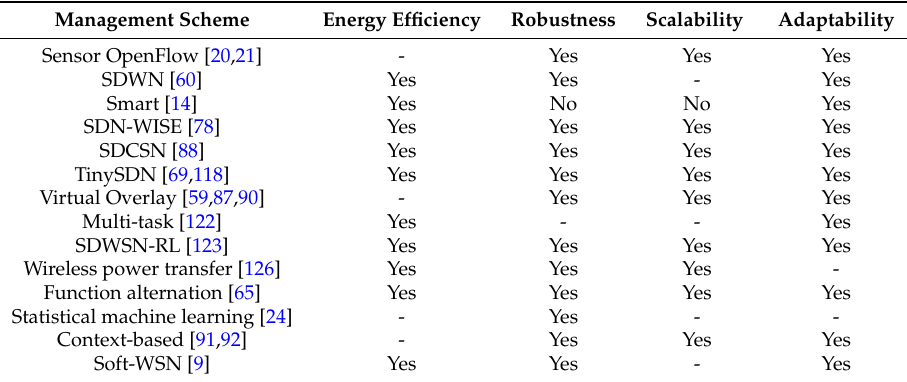
Table 5. SDWSN management scheme evaluation against design